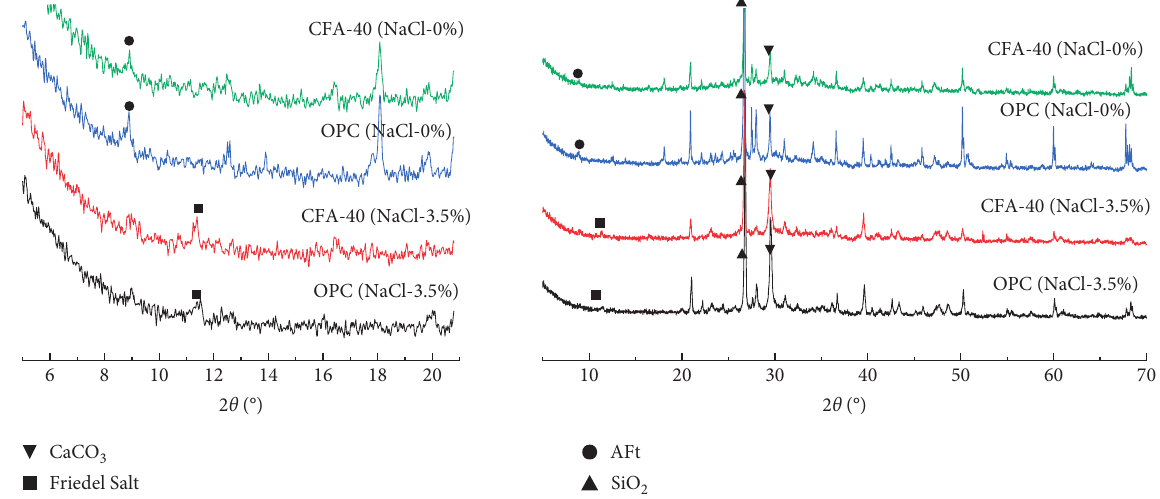
Figure 11: XRD patterns of concrete group